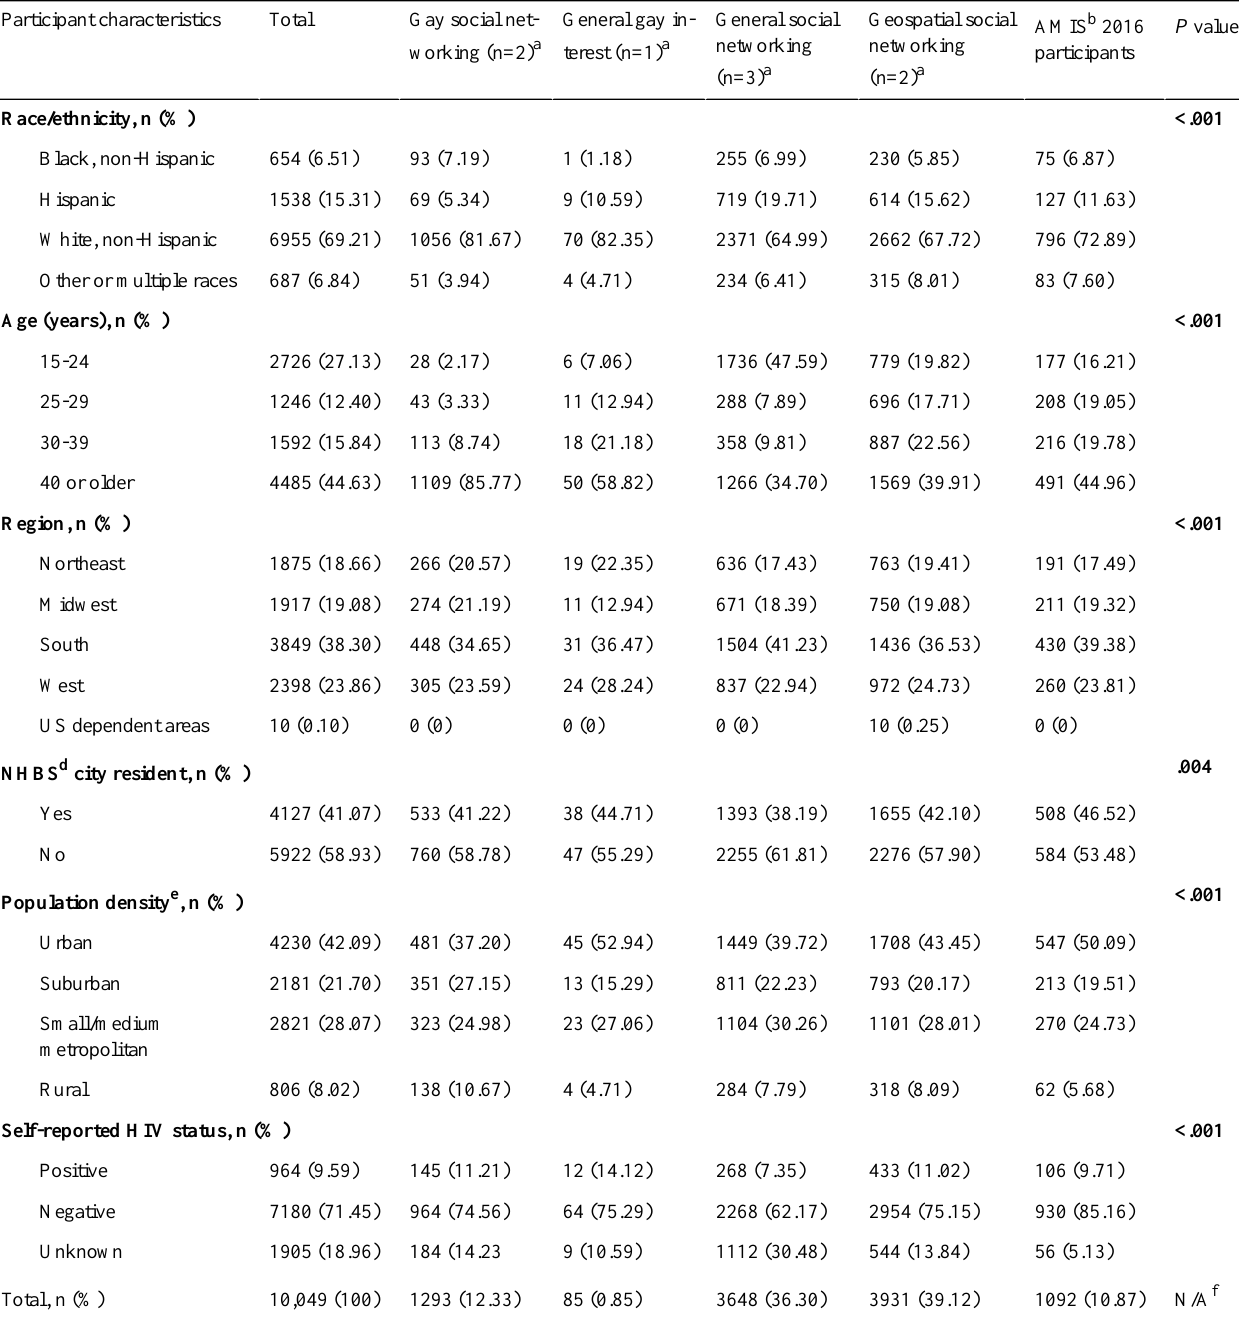
Table 2. Characteristics of men who have sex with men in the American Men’s Internet Survey by recruitment type, United States,